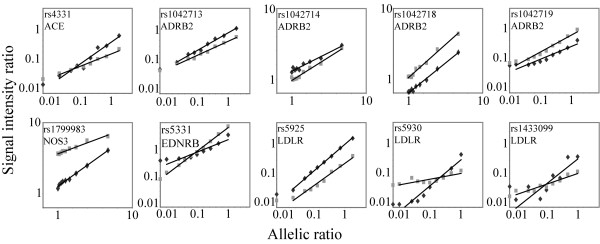
Regression lines displaying accuracy and sensitivity of quantitative genotyping of SNPs. The regression lines were obtained by analysing ten SNPs in a series of mixed samples with varying amounts of DNA from two individuals of different genotype. The signal intensity ratios from minisequencing using immobilised primers (Method I, black diamonds) and "tag-array" minisequencing (Method II, grey squares) are plotted as a function of the known allelic ratios in the mixed samples. The SNP names are given in the panels. The signal intensity ratios are mean values of five replicate reactions. The signal intensity ratios obtained in homozygous samples (allele ratios zero) are indicated as black diamonds and grey squares on the left vertical axis of each panel.